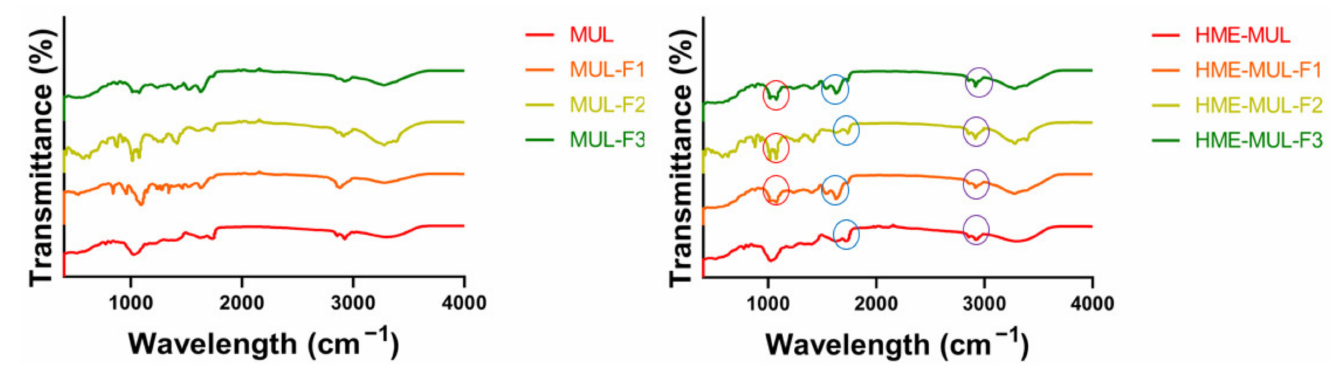
Figure 1. FT-IR analysis of the MUL extrudate’s solid formulation obtained using different chemi- cal